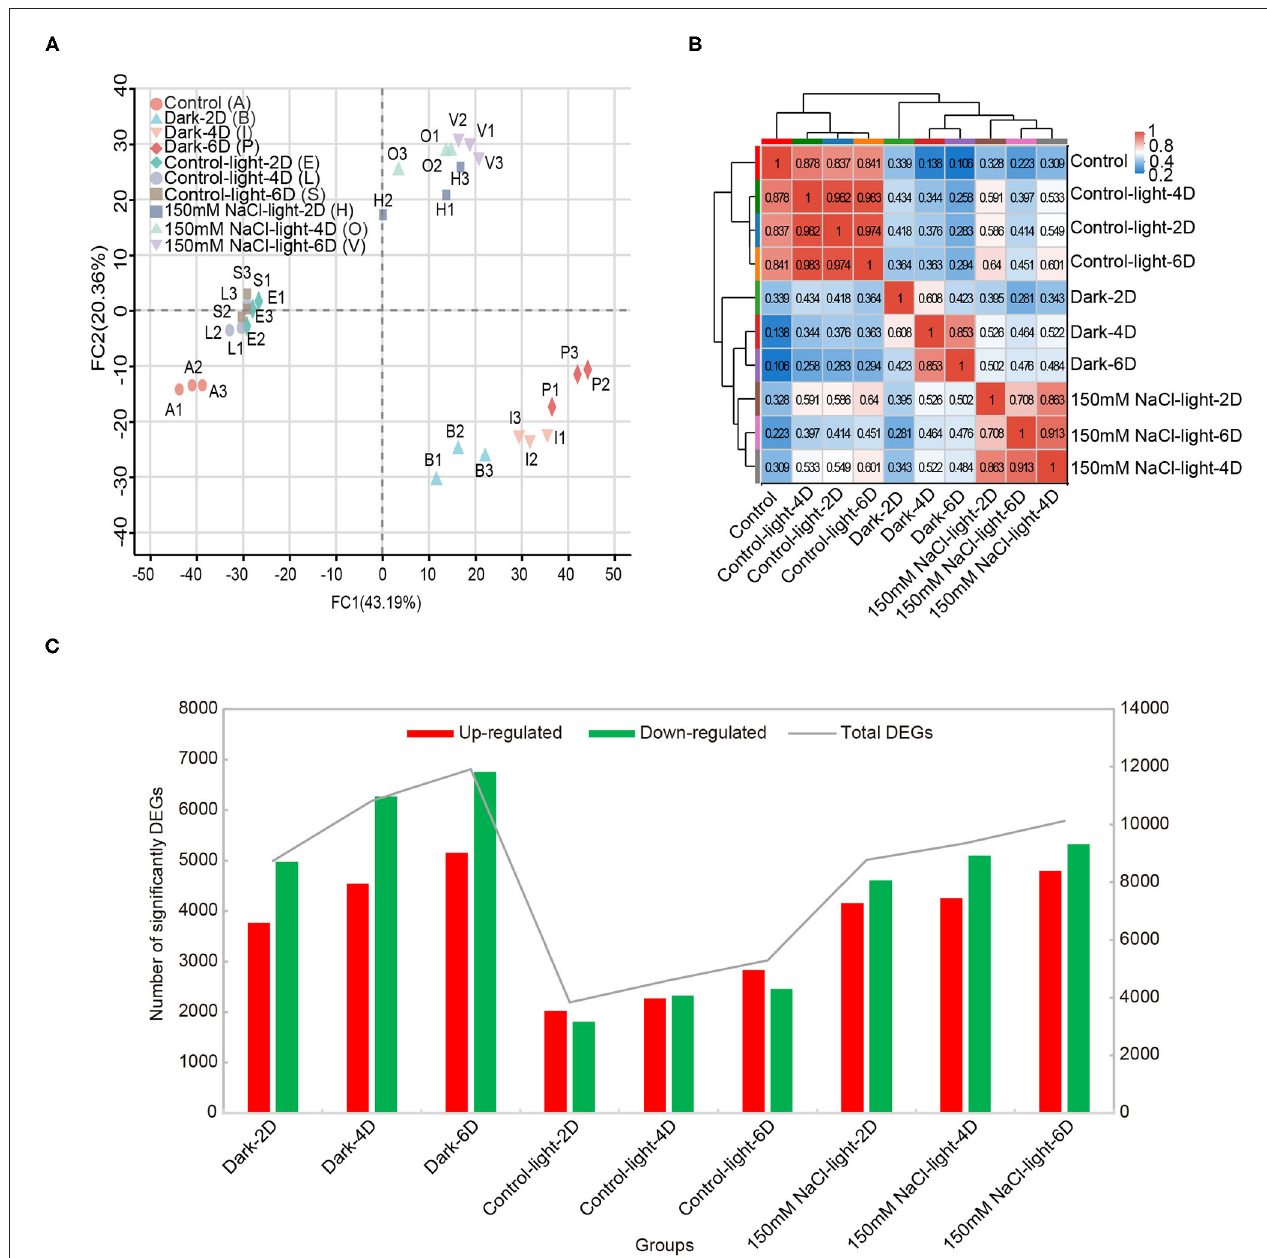
FIGURE 3 | Transcriptomic overview of salt stress-induced detached leaf senescence in Medicago truncatula . (A) Principal component analysis (PCA) plot of transcriptome profiles from different conditions. (B) Correlation analysis showed the direct association between samples in the same treatment. (C) The number of differentially expressed genes that were up- or down-regulated during leaf senescence compared with 0 day control prior to treatment, as assessed using the difference analysis software edgeR at thresholds of |log2FC| ≥ 1 or ≤ − 1 & P -adjust <